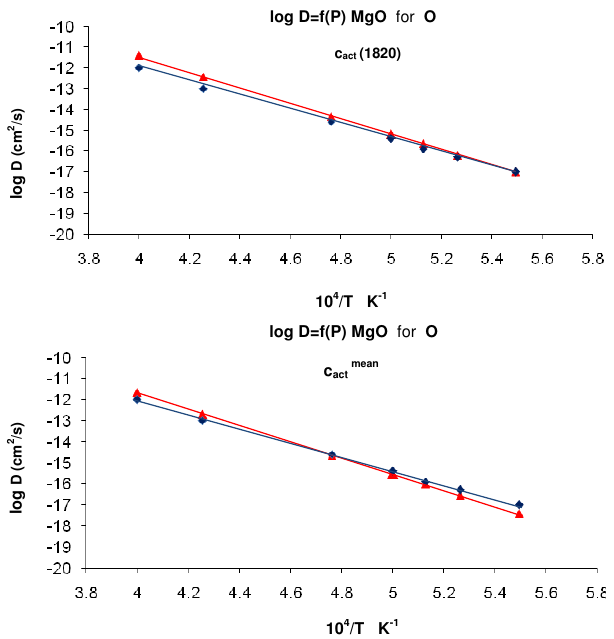
Fig. 1. Temperature dependence of the self diffusion coefficient of O in MgO. Red triangles denote the calculated data and blue dots the experimental ones. (a) for c act = 0.7243 at the lowest T = 1820K and (b) for the mean value c mean act =